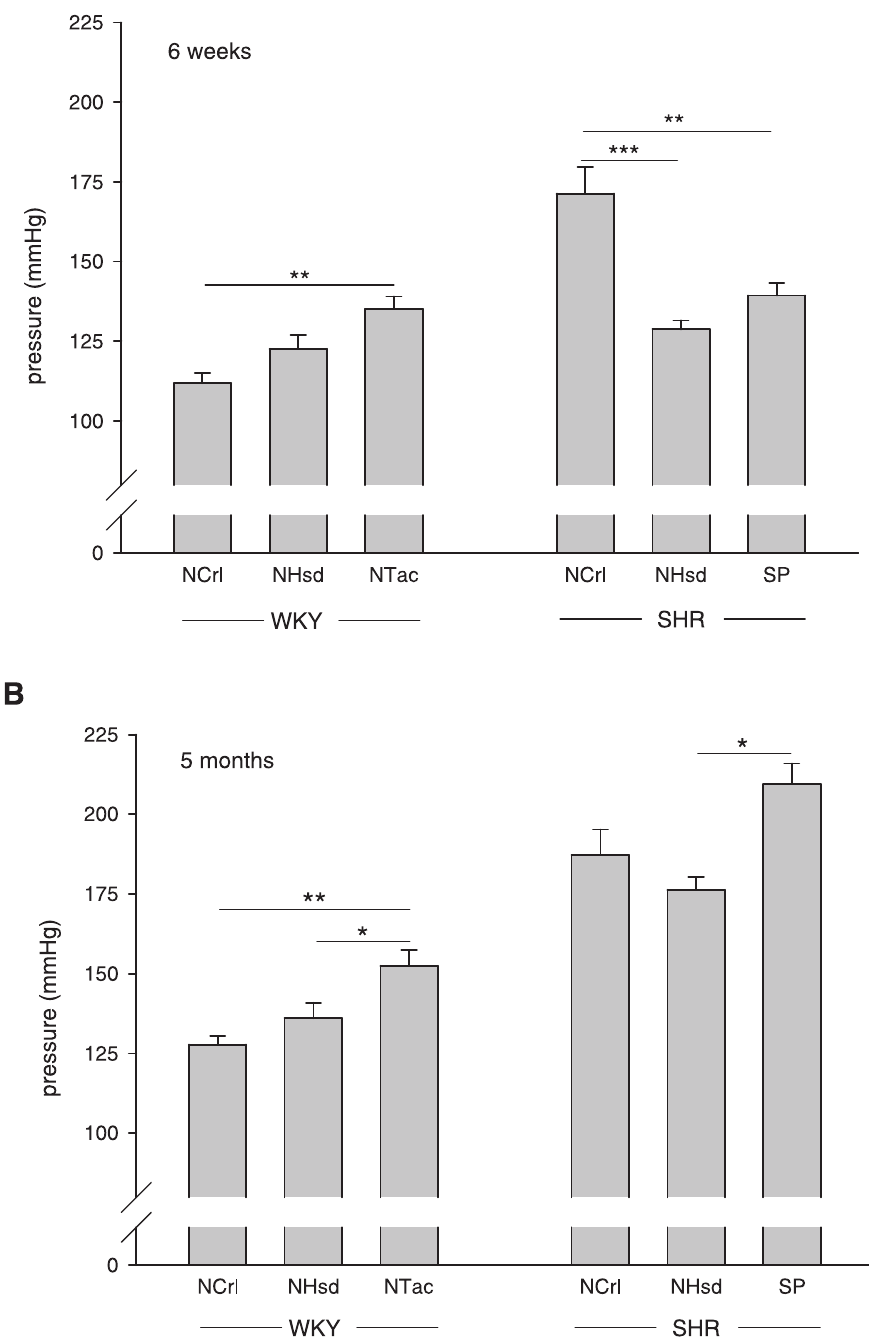
Figure 1. Blood pressure. Systolic blood pressures were measured using the tail cuff method at 6 weeks (panel A) and 5 months of age (panel B). Large differences between sublines were recorded in the level and development of blood pressure over time. Data are mean 6 SEM with WKY/NCrl 6 w: n=5 and 5 mo: n=6; WKY/NHsd 6 w: n=6 and 5 mo: n=4; WKY/NTac 6 w: n=5 and 5 mo: n=5; SHR/NCrl 6 w: n=5 and 5 mo: n=6; SHR/NHsd 6 w: n=6 and 5 mo: n=4; SHR/SP 6w: n=6 and 5 mo: n=6. *Indicates P , 0.05, ** P , 0.01 and *** P , 0.001. doi:10.1371/journal.pone.0107998.g001 However, when EC50 values were calculated, there was a significant difference in sensitivity between WKY/NCrl vs.